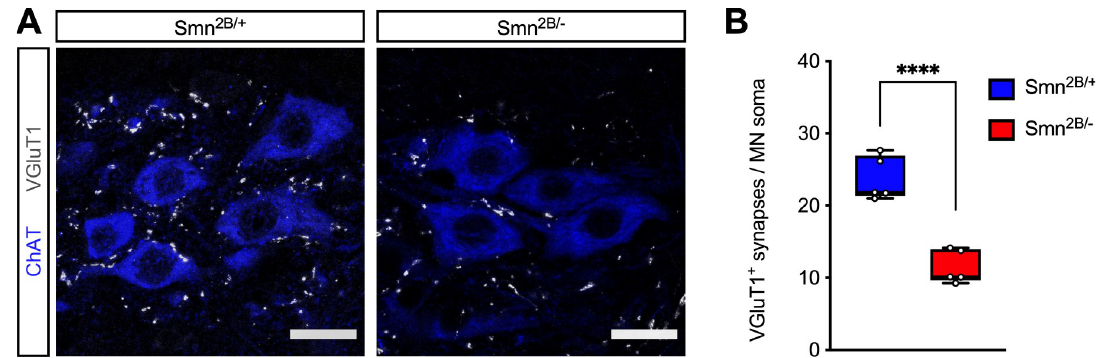
Fig 2. Smn 2B/- SMA mice display severe loss of proprioceptive synapses on motor neurons. (A) Immunostaining of VGluT1 + synapses (grayscale) and ChAT + motor neurons (blue) in the L2 spinal cord from control ( Smn 2B/+ ) and SMA ( Smn 2B/- ) mice at P16. Scale bars: 25 μ m. (B) Number of VGluT1 + synapses on the soma of L2 motor neurons from the same groups as in (A) at P16. The box- and-whiskers graph shows the individual values, median, interquartile range, minimum and maximum from 5 mice per group. Statistics were performed with two-tailed unpaired Student’s t-test. ���� P <